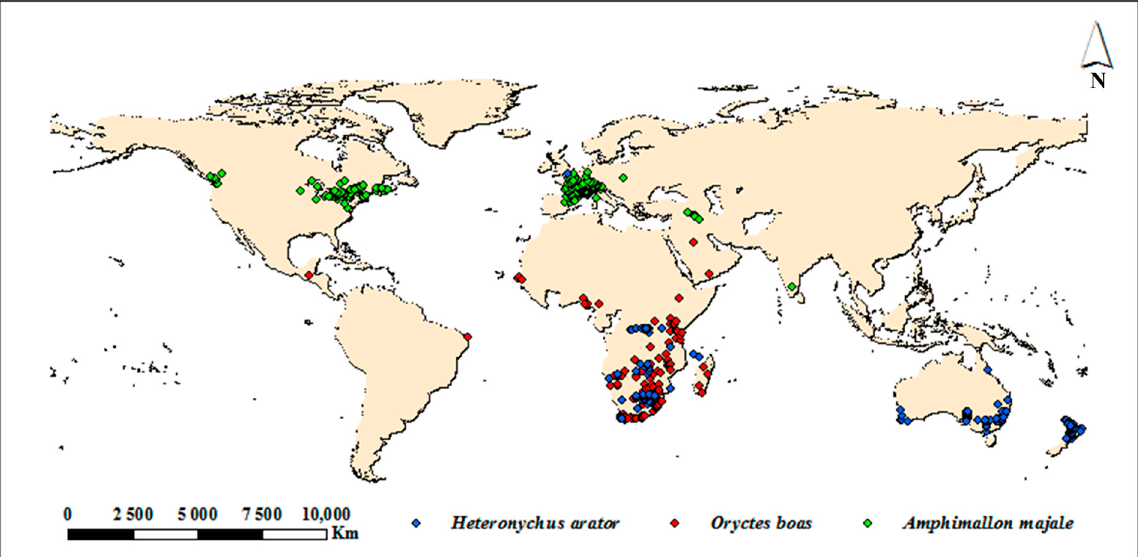
Figure 1. Occurrence records of Heteronychus arator , Oryctes boas and Amphimallon majale . Three different-colored dots indicate distribution records.